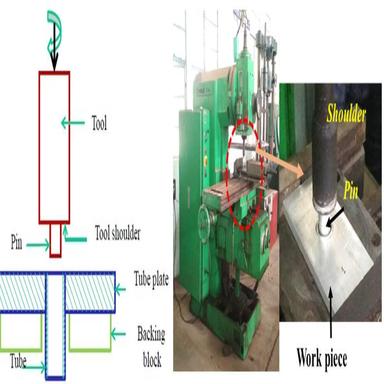
Schematic diagram of FWTPET set-up.